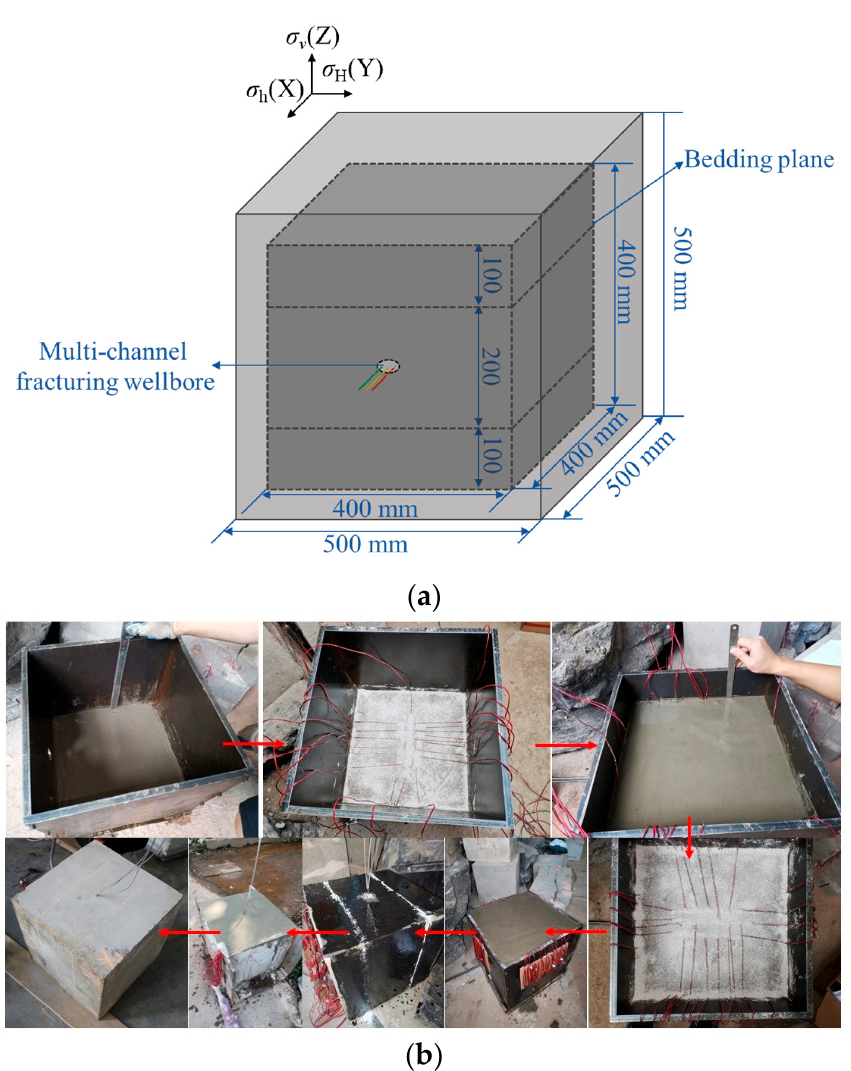
Figure 3. Composite wrapped layered sample: ( a ) cutaway view of sample structure; ( b ) preparation process.